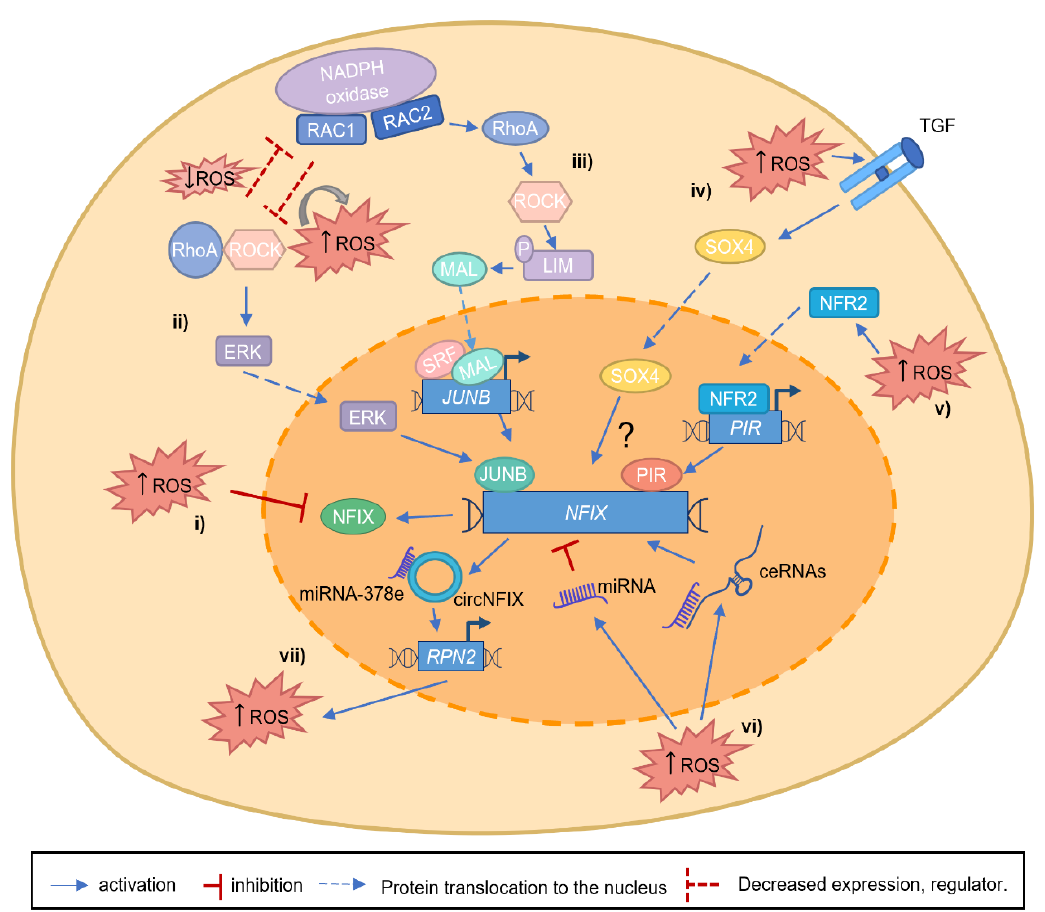
Figure 3. Putative mechanisms linking NFIX and increased ROS levels . ( i ) During tissue develop- ment, ROS can regulate NFIX expression, oxidizing specific NFIX cysteine residues. ( ii ). RAC1, a catalytic subunit of NADPH oxidase, can generate ROS and interact with RhoA/ROCK axis leading to its activation or inhibition. On the other hand, RhoA, through its target gene ROCK, can inhibit RAC1 activity, decreasing ROS levels. When RAC1 is able to activate the RhoA/ROCK axis and increase ROS levels, ERK kinases are activated, leading to JUNB activation, and consequently, JUNB activates NFIX expression. ( iii ) The increased expression of RAC2, and subsequent ROS production, lead to the activation and increase in RhoA and its targets, such as ROCK, that will phosphorylate LIM kinase. With LIM kinase phosphorylation, MAL translocates to the nucleus activating SRF. Consequently, SRF activates JUNB expression, and JUNB protein binds to the NFIX promoter, acti- vating its transcription. ( iv ) NFIX is a putative target gene of SOX4, but the exact mechanism remains unknown (question mark). SOX4 activation is mediated by ROS/TGF β , and it is possible that this protein can translocate to the nucleus activating NFIX expression. ( v ). The oxidative stress sensor NRF2 is activated by increased ROS levels, allowing its translocation to the nucleus, where it activates the Pirin ( PIR ) promoter. Consequently, NFIX expression is induced through the binding of Pirin to the NFI I/CCAAT box transcription factor (NFI/CTF1) domain. ( vi ) ROS can lead to the activation of miRNAs or ceRNAs (network composed by miRNA and the inhibitory binding through lncRNA), which lead to a decrease or an increase in NFIX expression, respectively. ( vii ) In gliomas, miR-378e functionally targets RPN2, an oncogene, and ROS inducer, inhibiting its onco- genic functions. circNFIX can sponge the action of miR-378e, allowing RPN2 activity (as part of the ceRNA network), contributing to glioma progression.